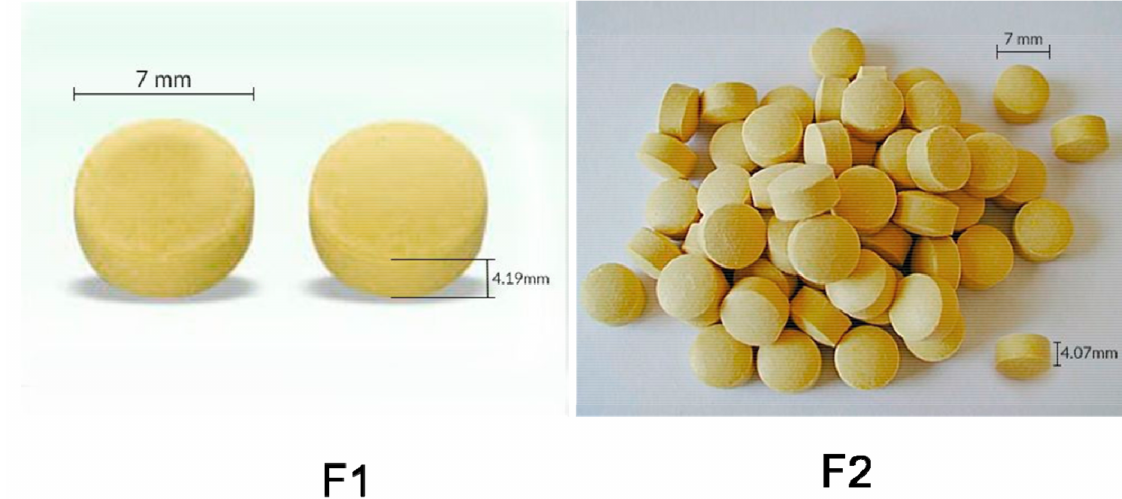
Figure 8. The digital images of the obtained